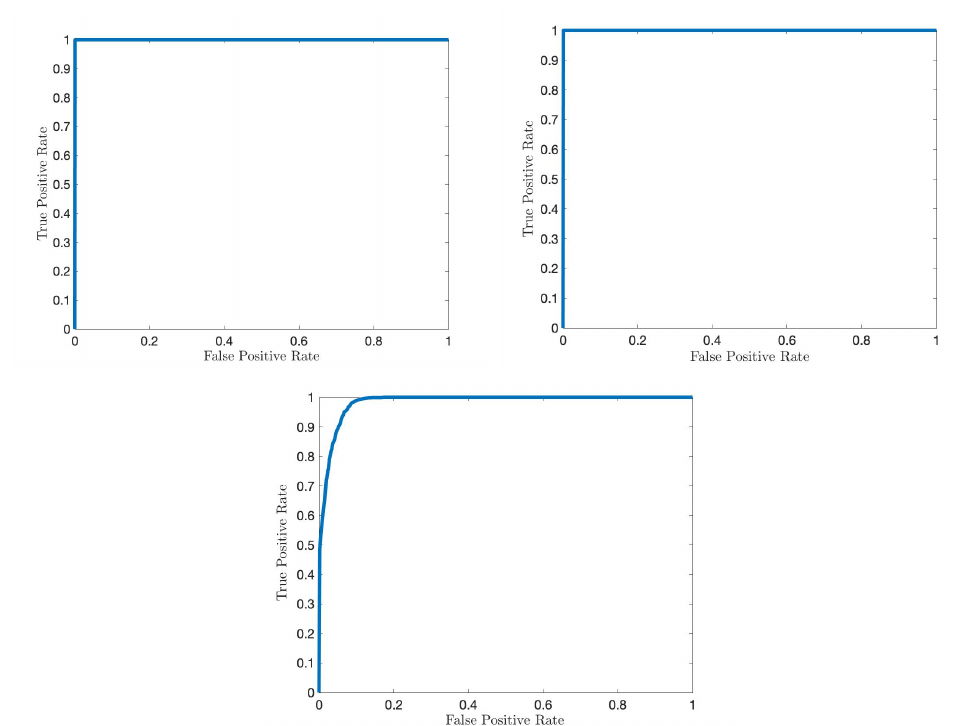
Figure 13. ROC curves for the proposed IDS’s anomaly localization performance: identification of anomalous vehicles in FDI attack to speed data ( top left ), identification of anomalous data in FDI attack to speed data ( top right ), and identification of anomalous road segments in DDoS attack ( bottom